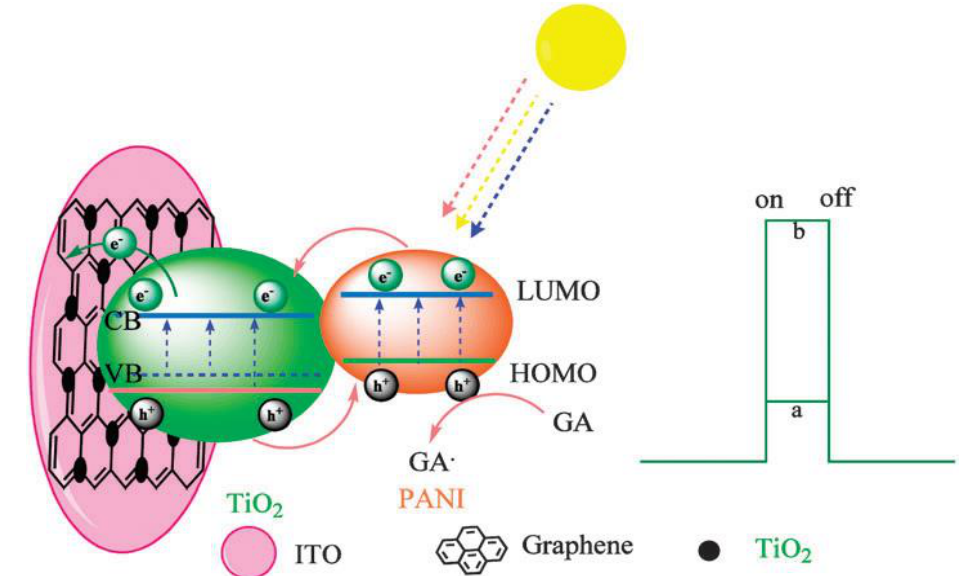
Figure 7. Schematic illustration of the photoelectrochemical process for GA oxidation at a polyaniline (PANI)–rGO–TiO 2 modified electrode. Taken from Ma et al. [175].